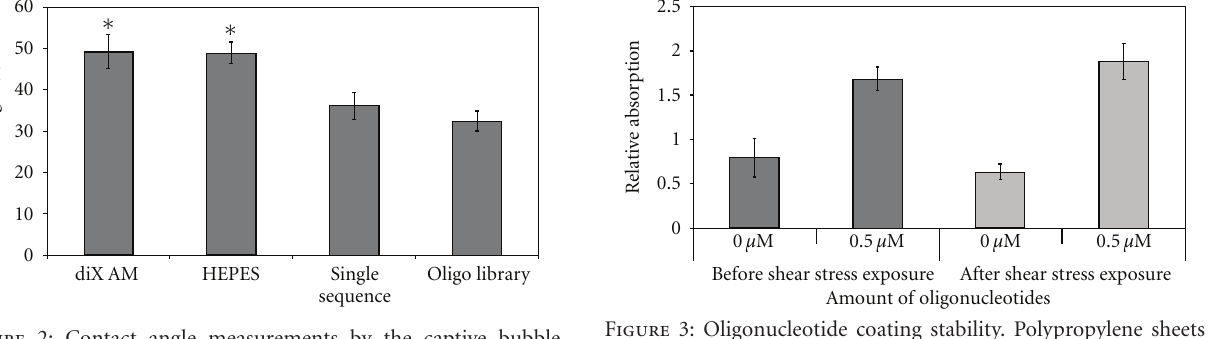
Figure 2: Contact angle measurements by the captive bubble method using PBS. Contact angle was significantly lower for oligonucleotide coated samples compared to diX AM or HEPES treated samples ( ∗ , P < 0 . 05, n = 6).